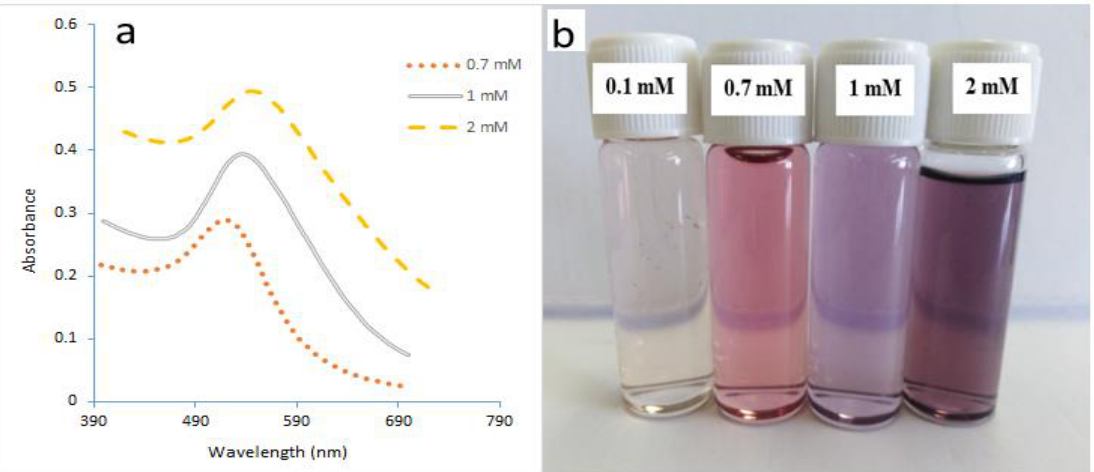
Figure 5 . ( a ) UV spectra of GNPs samples prepared in a microreactor at various gold concentrations. ( b ) GNPs ’ colors (Temperature = 308.15 K, total flowrate of SB and gold with SC = 1.66 × 10 −5 L/s, Volumetric ratio of SB/HAuCl 4 = 4:10, pH i = 3).